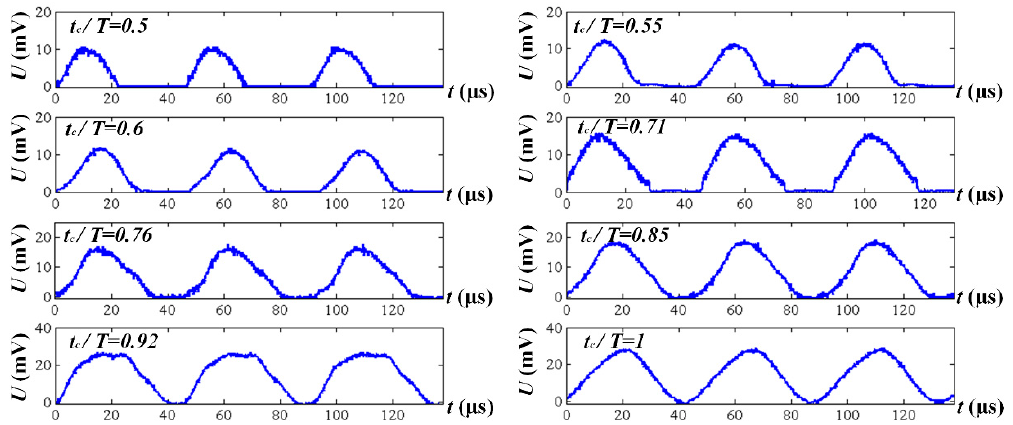
Figure 5. Transient cutting force signals of di ff erent cutting